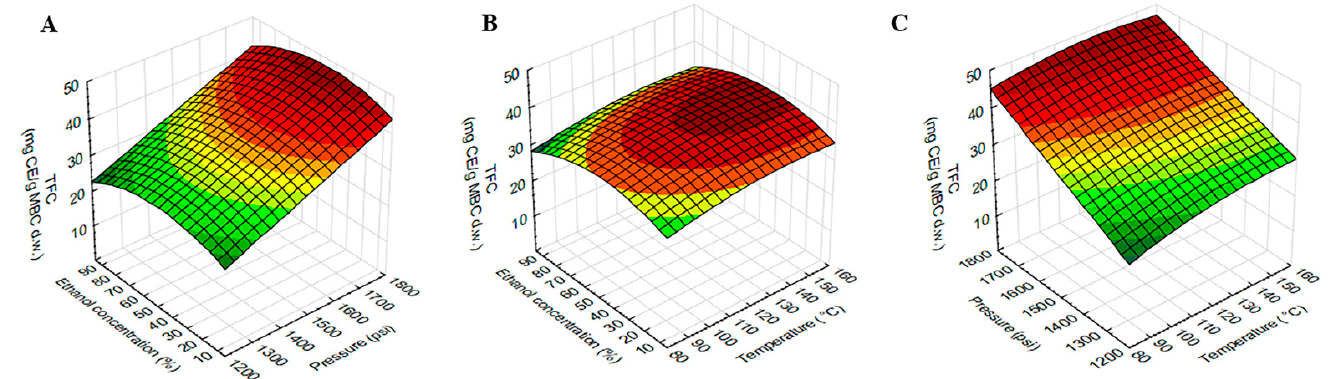
Figure 3. Response surface plots showing the interaction effects of extraction variables on TFC of MBC extract. ( A ) pressure and ethanol concentration at constant temperature (120 ◦ C), ( B ) temperature and ethanol concentration at constant pressure 1500 psi and ( C ) temperature and pressure at constant ethanol concentration (50%).